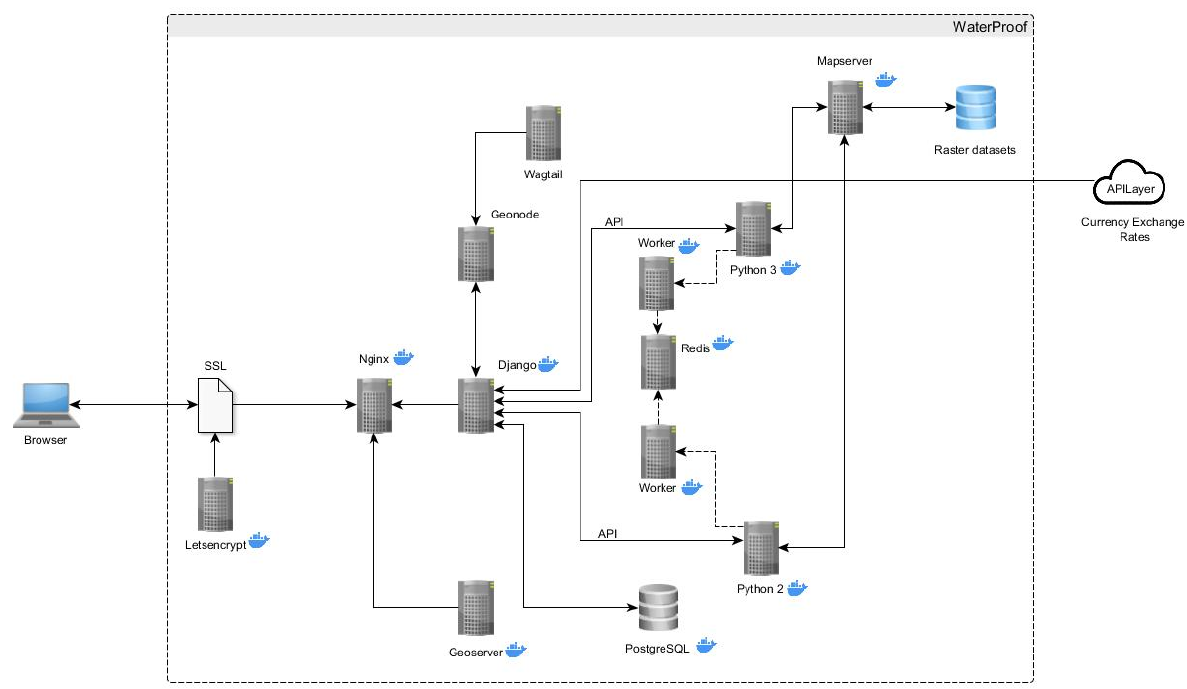
Figure 6. WaterProof ’s software architecture.